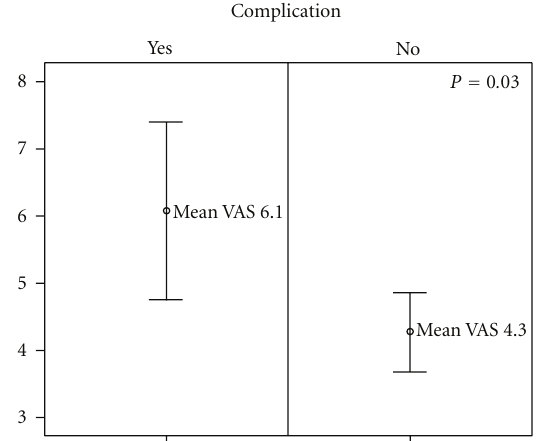
Figure 1: Parents’ rating of their experience of their child’s SCHF on a visual analogue scale (VAS) according to if the child experienced complications to the fracture or not. VAS 0 = “no problem at all”, 10 = “a terrible experience.” Mean VAS ± 2 standard error of the mean